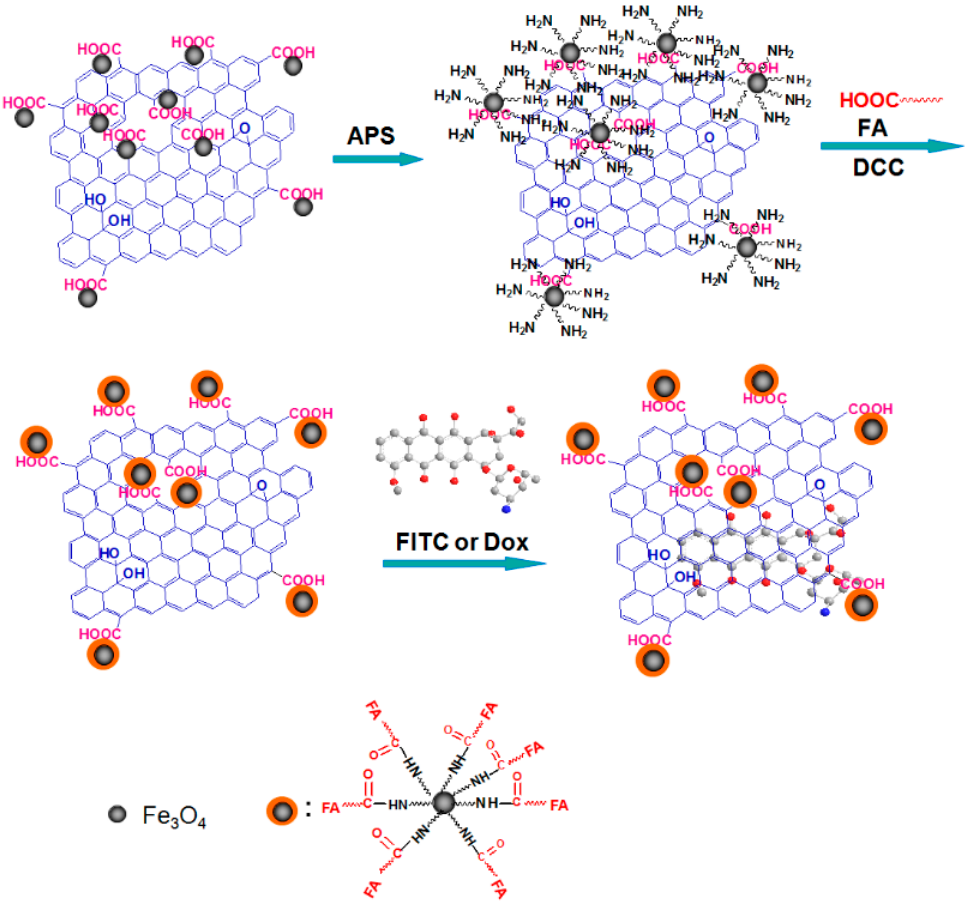
Figure 6. Synthesis of a multi functionalized drug delivery system based on GO and magnetite NPs. (Reproduced with permission from [99]. Copyright 2011, Royal Society of Chemistry).